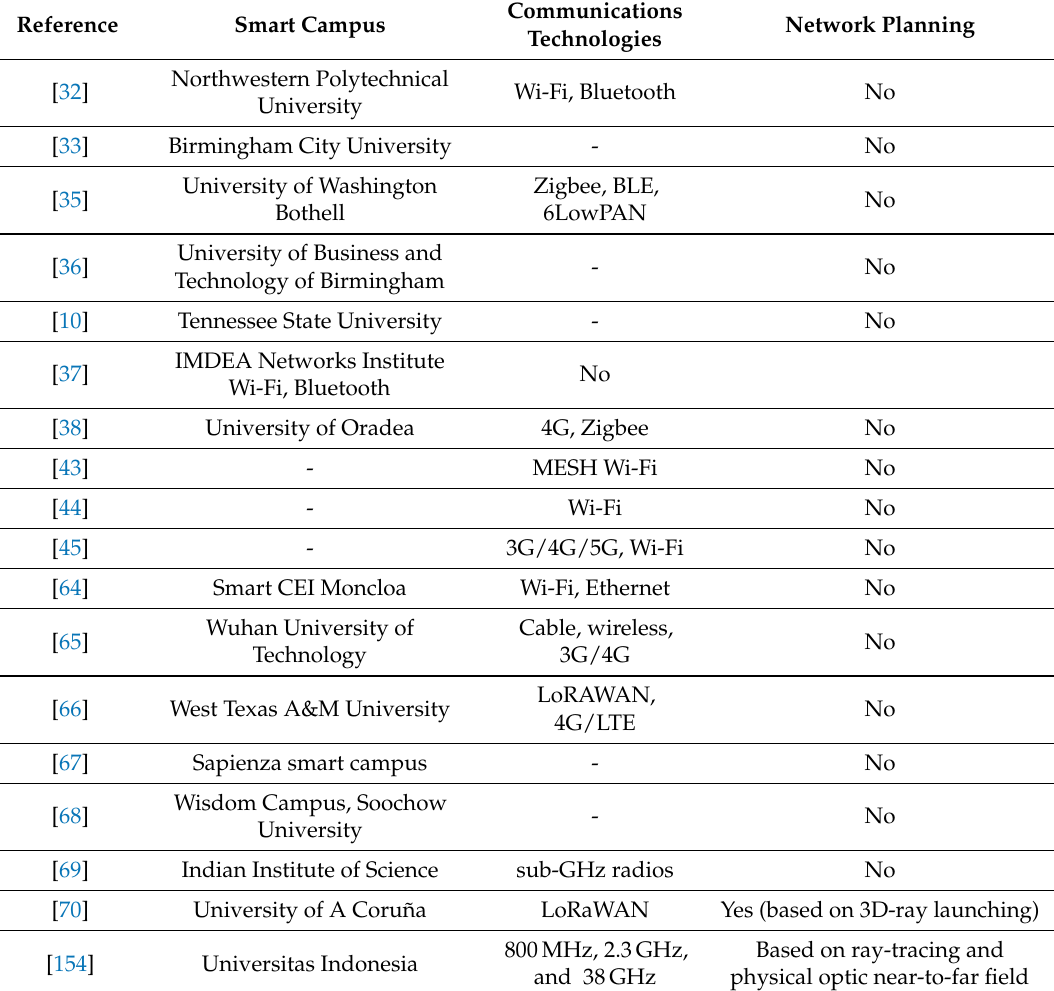
Table 3. Communications technologies of the most relevant smart campuses